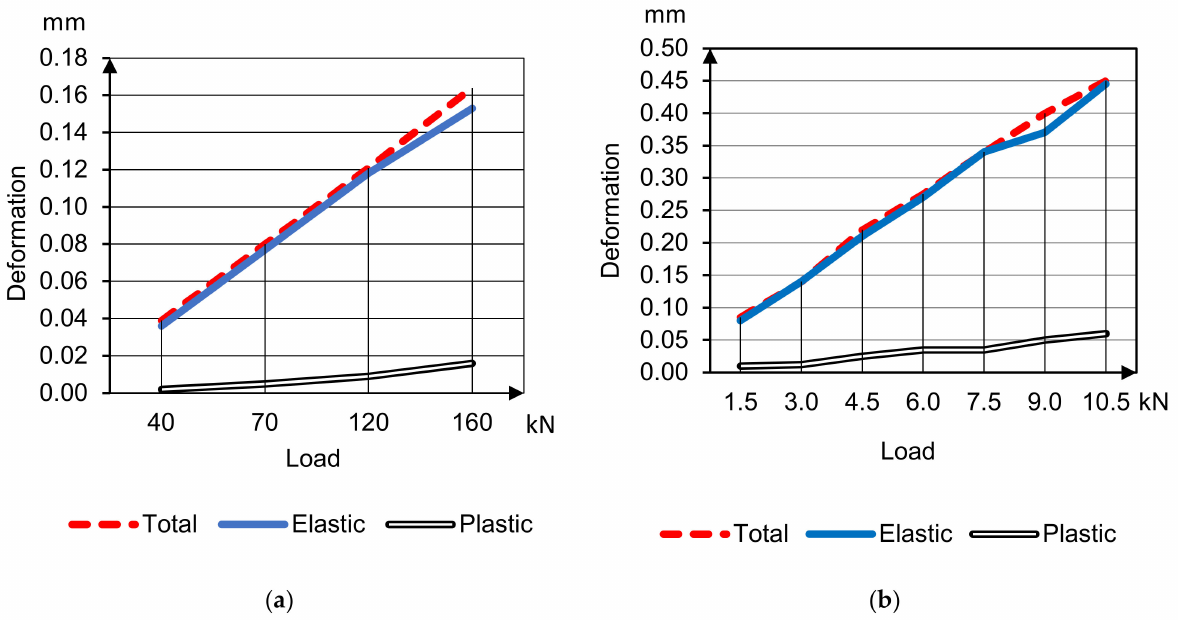
Figure 7. Deformation and deflection curves for concrete 2 under compression ( a ) and bending ( b )